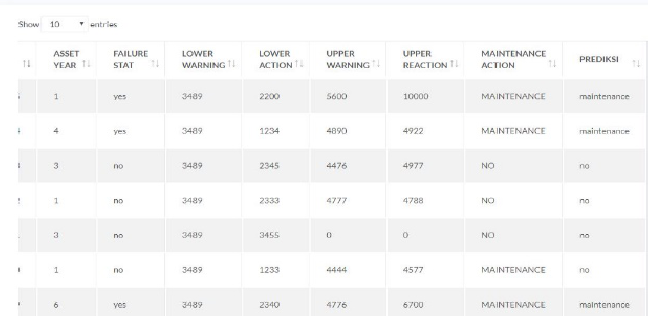
Fig. 14. Overall Data Prediction